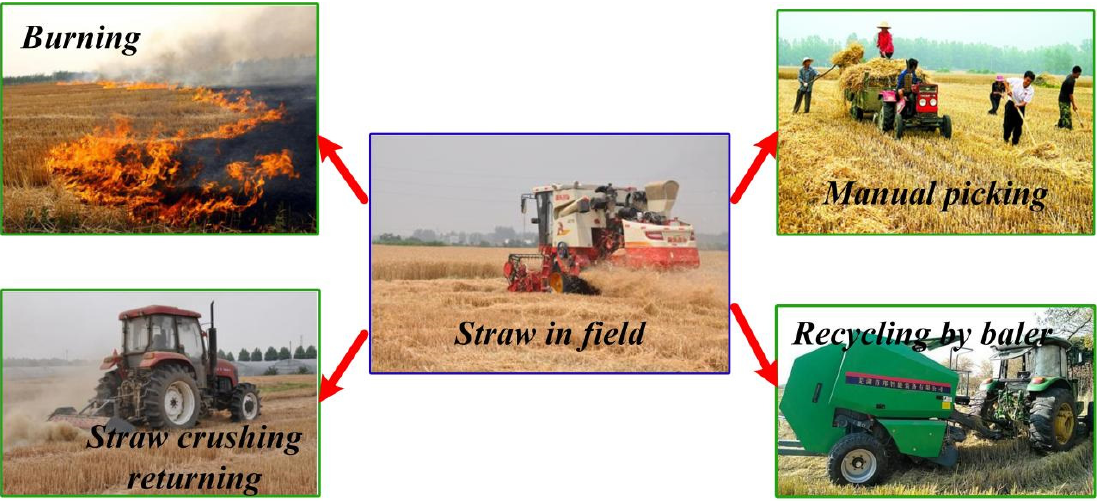
Figure 1. Various ways to deal with straw scattered in the field.